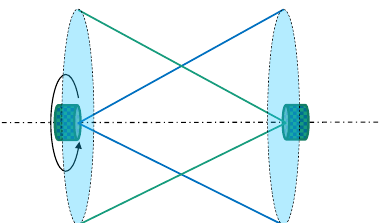
Figure 1. Ideal rotary arrangement: transmitter (TX) (blue) and receiver (RX) (green) of a transceiver are placed on the optical axis at the same position. The field of view (FOV) of TX and RX overlap ideally. For high-speed bidirectional data transfer in full-duplex mode, TX and RX are separated.